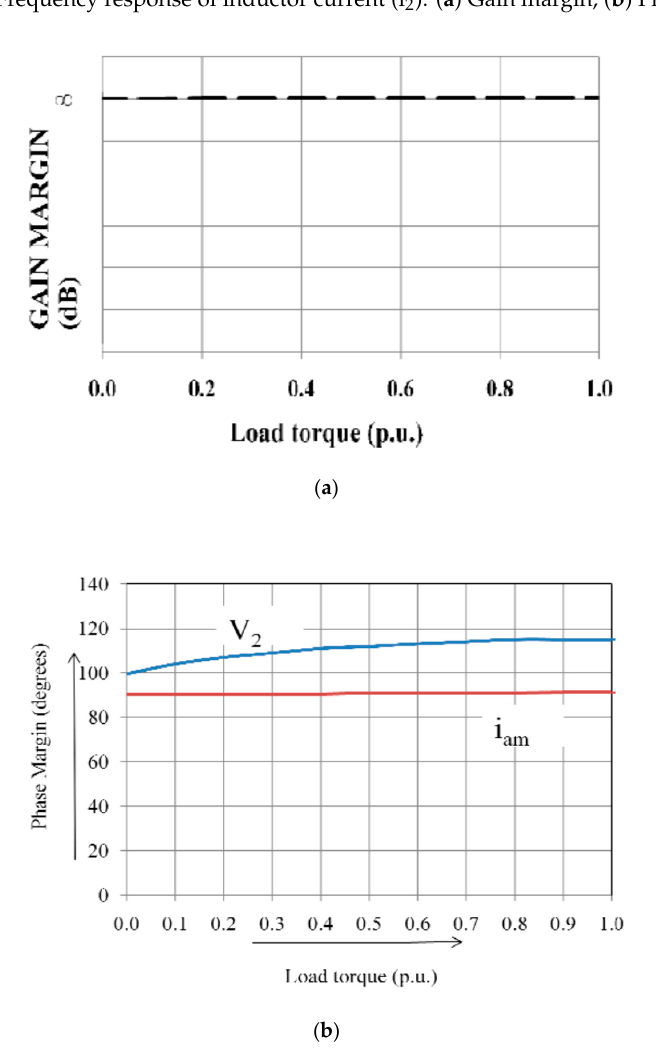
Figure 14. Frequency response of armature voltage (v 2 ) and armature current in (i am ). ( a ) Gain margin— v 2 and i am ; ( b ) Phase margin—v 2 and i am